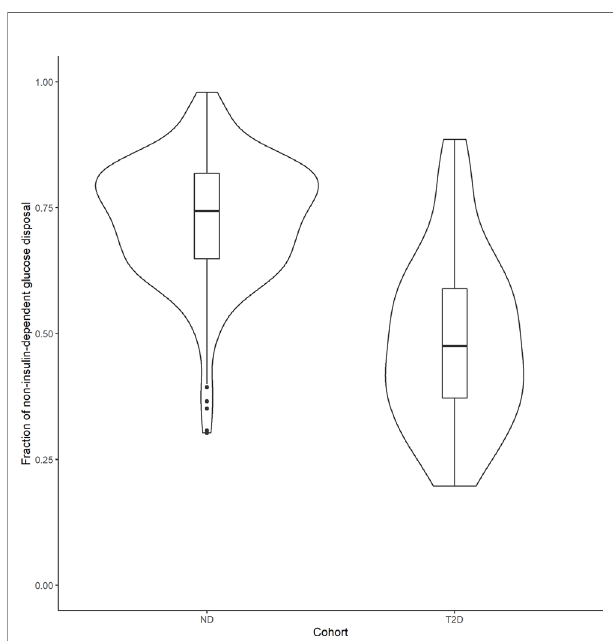
FIGURE 5 | Violin plots showing the distribution of the fraction of non – insulin-dependent net glucose disposal in 238 ND subjects and 30 T2D patients that underwent an IVGTT test. Boxplots were inserted for each cohort to indicate medians and interquartile